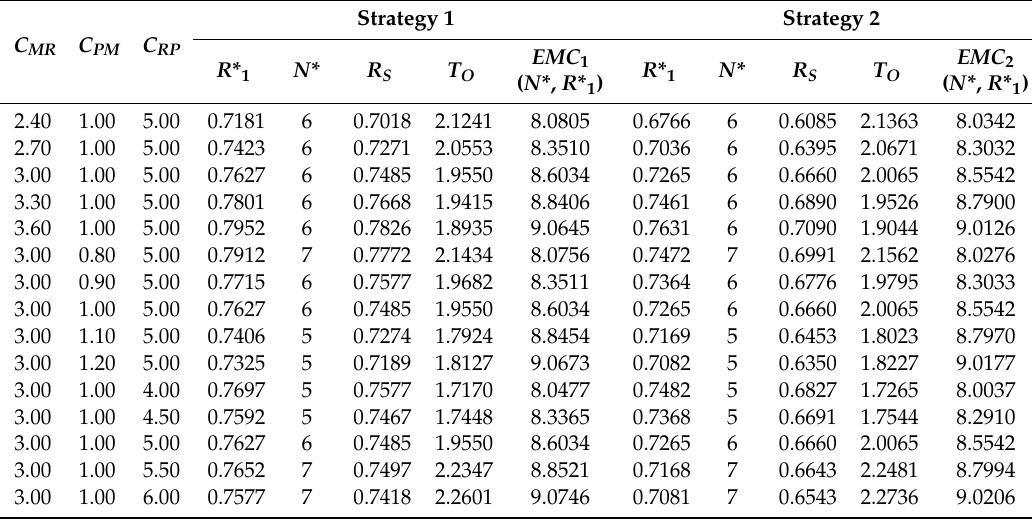
Table 7. Results of sensitivity analysis related to maintenance